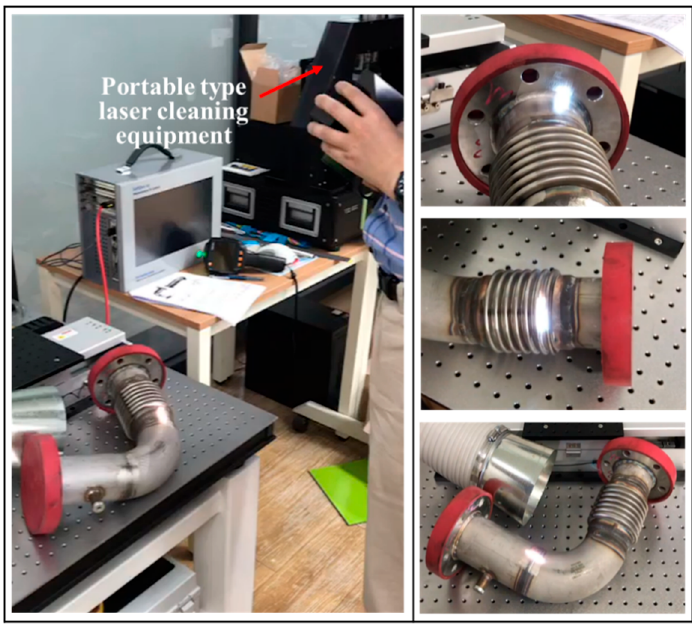
Figure 10. Laser cleaning application of gas fuel supply pipe prototype.